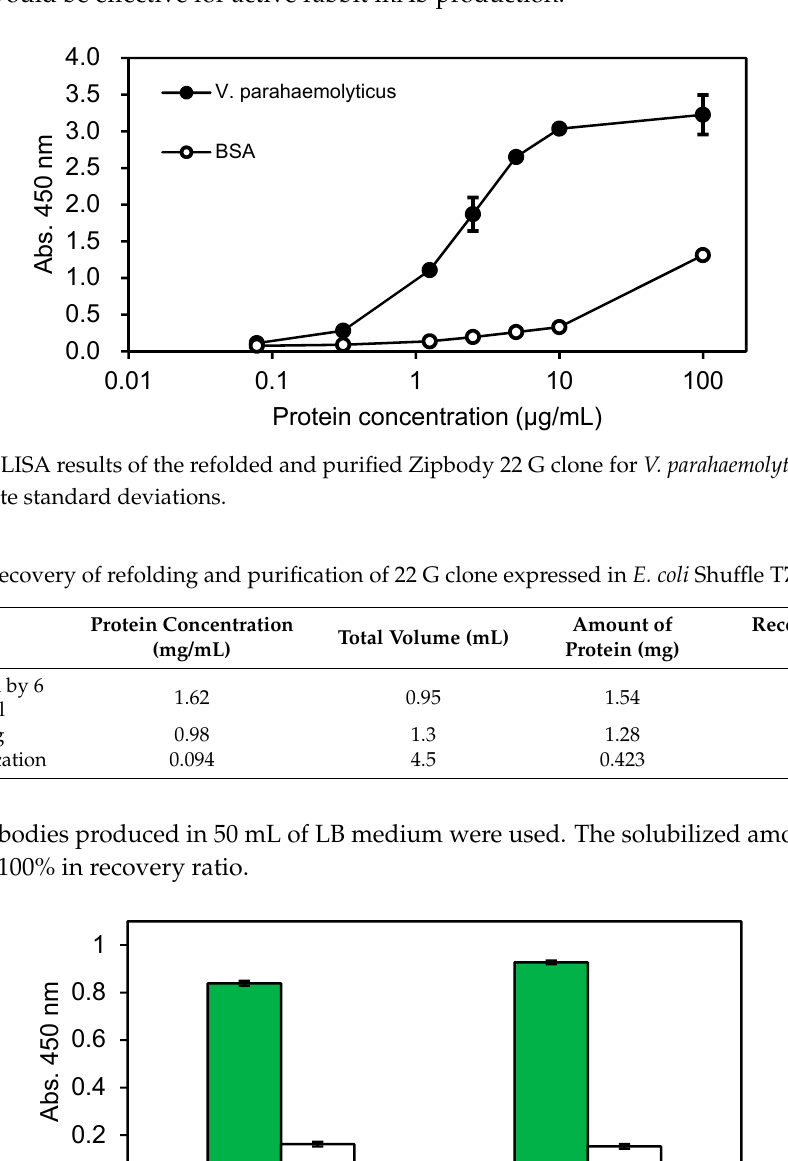
( c ) Figure 2. Enzyme-linked immunosorbent assay (ELISA) results of the cell-free products. Antigens are ( a ) Vibrio parahaemolyticus . ( b ) Escherichia coli O26, and ( c ) nontoxic VT2. Green: Antigen, White: Bovine serum albumin (BSA). N. C. means no DNA templates in the cell-free protein synthesis (CFPS) reaction. Error bars indicate standard deviations. 3.2. Expression in E. coli From the above obtained mAb clones, 22 G for V. parahaemolyticus and 14 G for nontoxic VT2 were selected for next E. coli expression and further investigation. The Zipbody with N-terminal SKIK peptide tag of clone 22 G was expressed in E. coli Shuffle T7 Express. Since most of the target proteins were produced as inclusion bodies, refolding was tried. As a result, 82.8% of the refolded proteins was recovered as soluble fraction (Table 1). Finally, 27.4% was recovered as purified protein by His